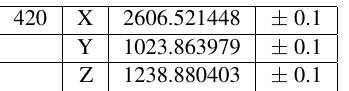
Table 8: Resulting coordinates of the center of the mounted target from photogrammetric